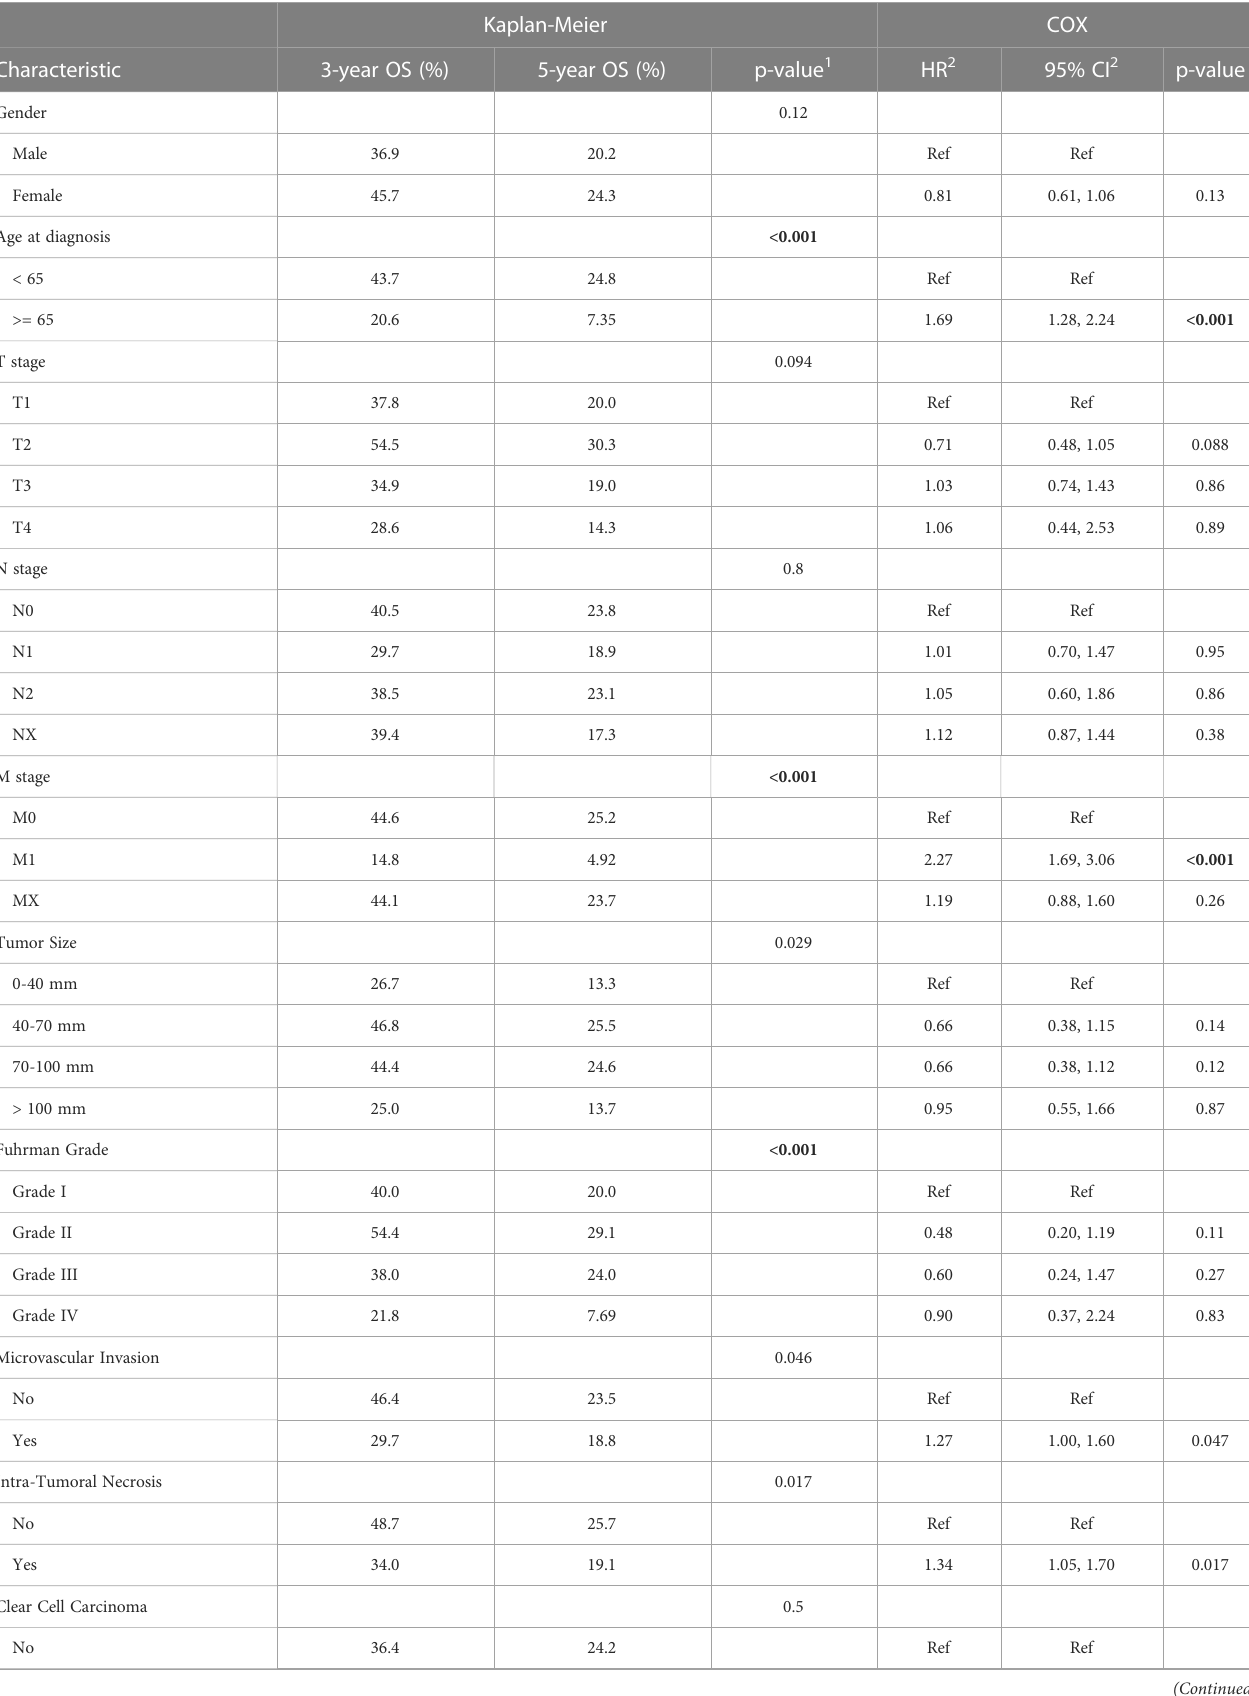
TABLE 2 Kaplan – Meier analysis and univariate Cox regression of overall survival (OS) starting fi rst-line of systemic treatment for patients of this study.